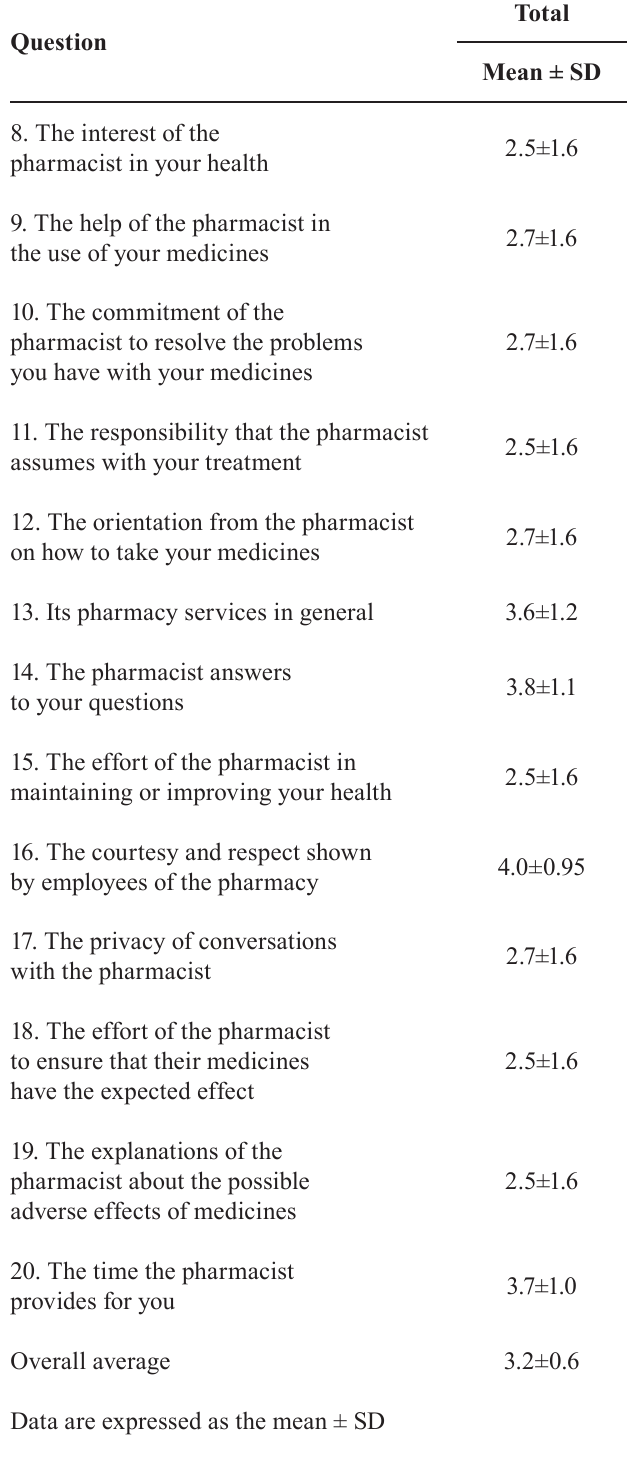
TABLE IV - Overall satisfaction levels for each item of the satisfaction questionnaire for pharmacy services, mean and standard